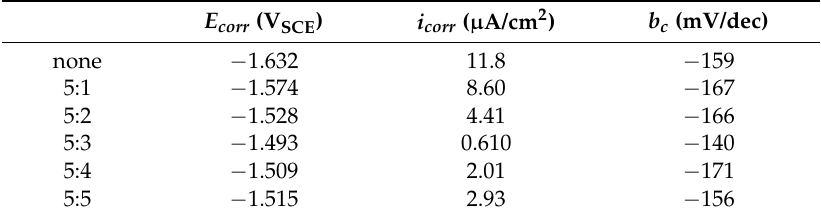
Table 2. The fitting results of polarization curves shown in Figure 1b.